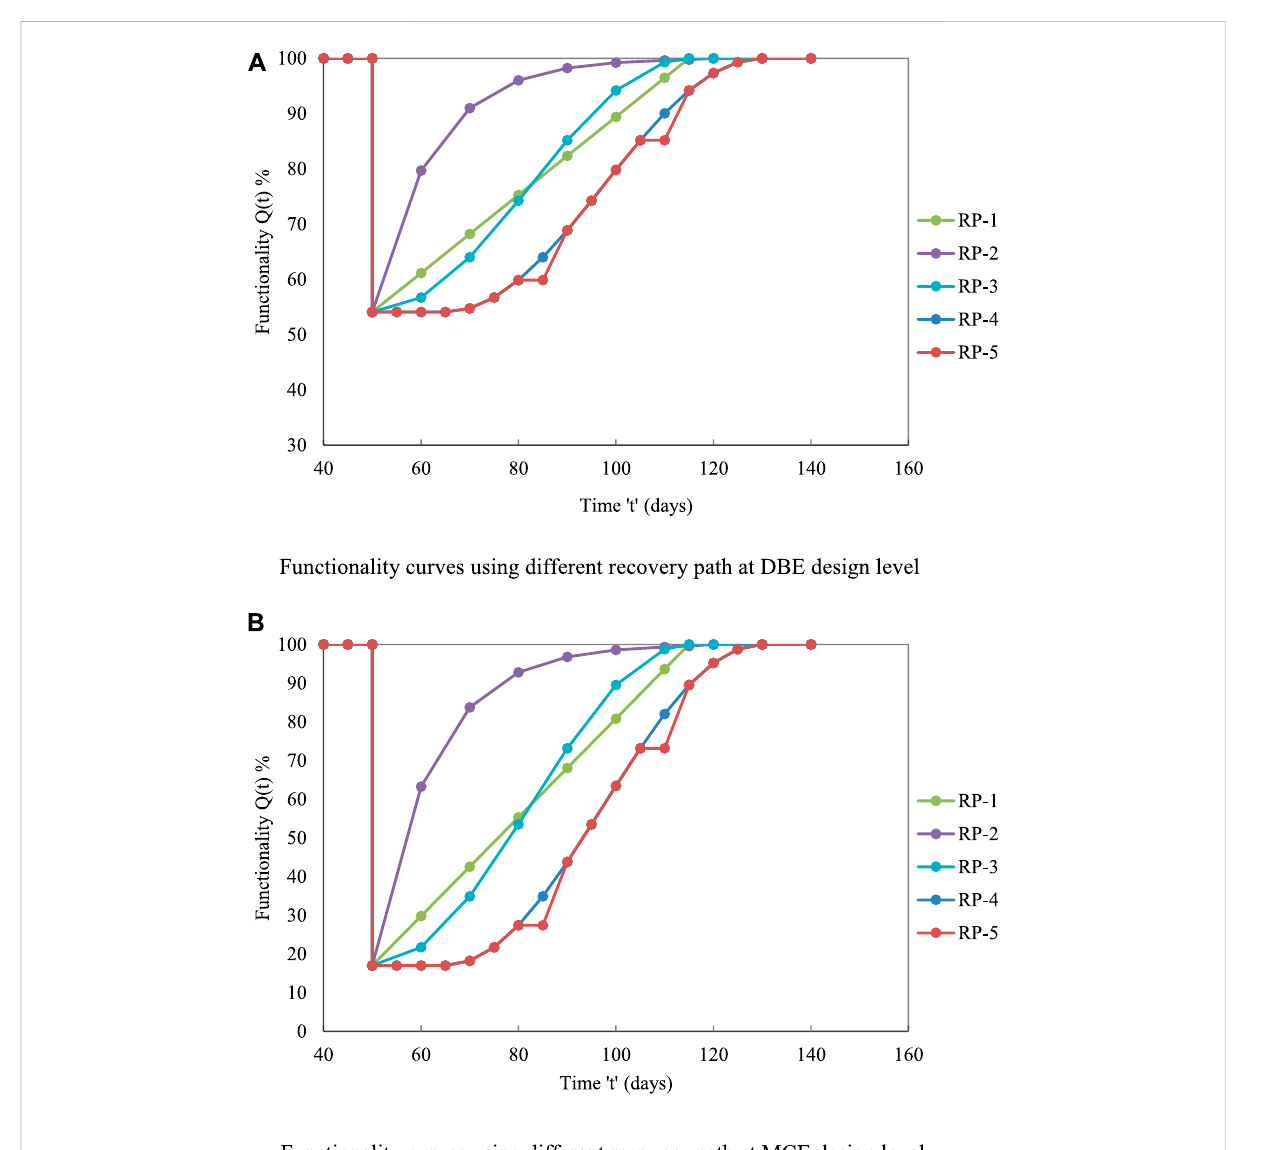
FIGURE 9 Functionality curves for case III building with respect to various recovery paths. (A) Functionality curves using different recovery paths at DBE design level. (B) Functionality curves using different recovery paths at MCE design level.